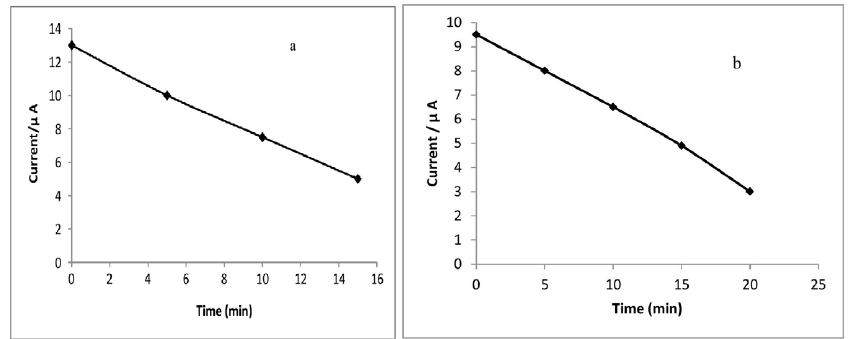
Fig. 7.a. Visible spectra of the Ponceau 4R dye solution drawn out at intervals of time from the electrochemical cell during the elec- tro-oxidation process and (b) Alizarin red dye [DYE] = 2